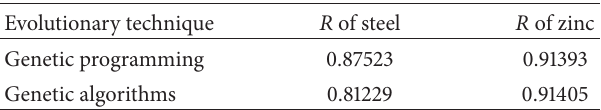
Table 7: Summary of Model-Identification Goodness of Fit (values 𝑅 ).